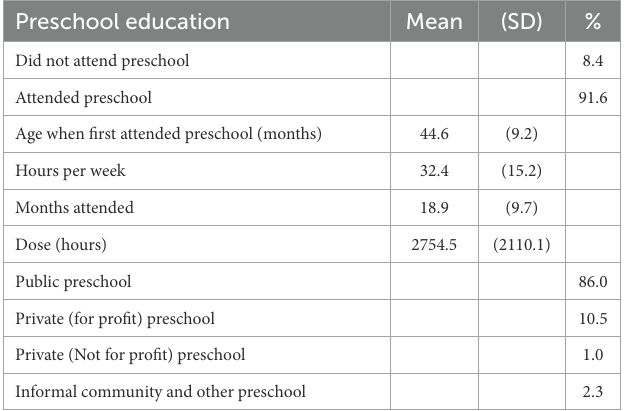
TABLE 3 Vietnamese children’s preschool attendance between 3 and 5 years of